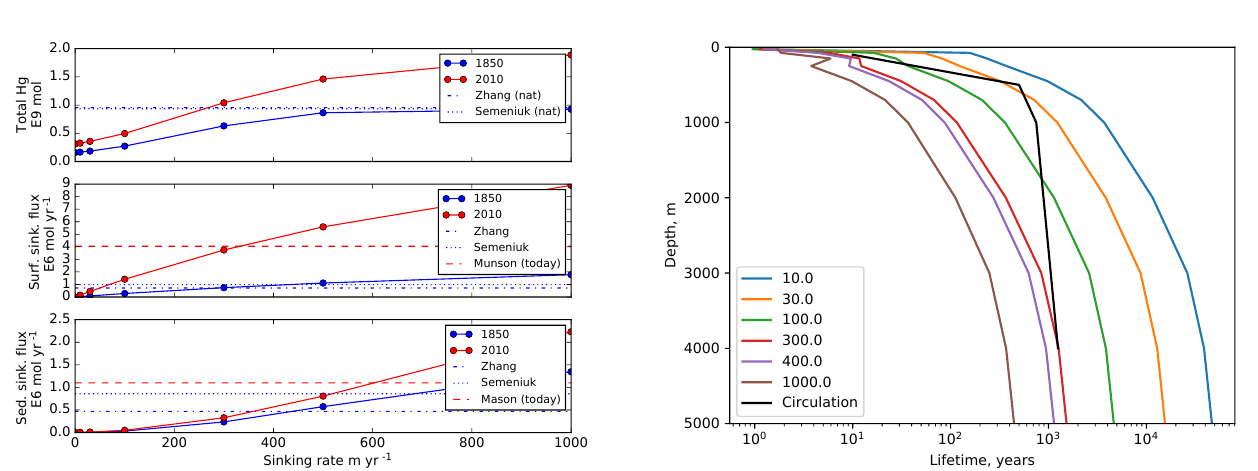
Figure 7. Profiles of the turnover time of Hg(II) with respect to transiting through the system on sinking particles, as a function of the sinking velocity in the legend, in meters per year (myr − 1 ). The black line is the water age since exposure to the atmosphere derived from the 14 C distribution (Gebbie and Huybers,